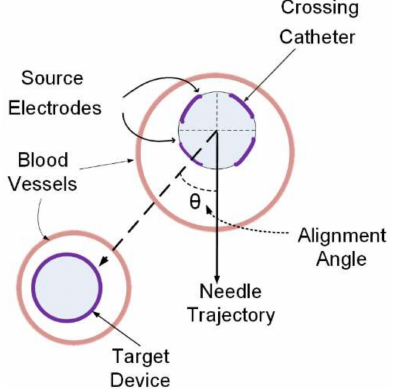
Figure 1. Arrangement of two catheters in the vessels.